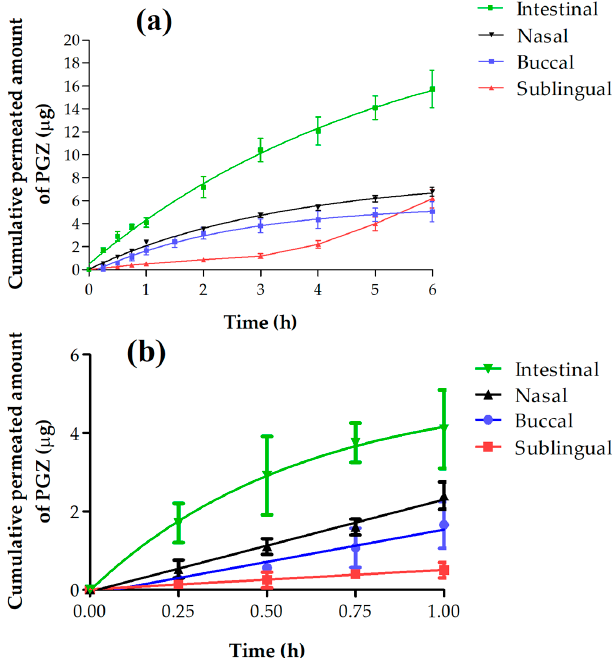
Figure 1. ( a ) Cumulative permeated amount of Pioglitazone (PGZ) within 6 h; ( b ) Cumulative permeated amount of PGZ within 1 h.